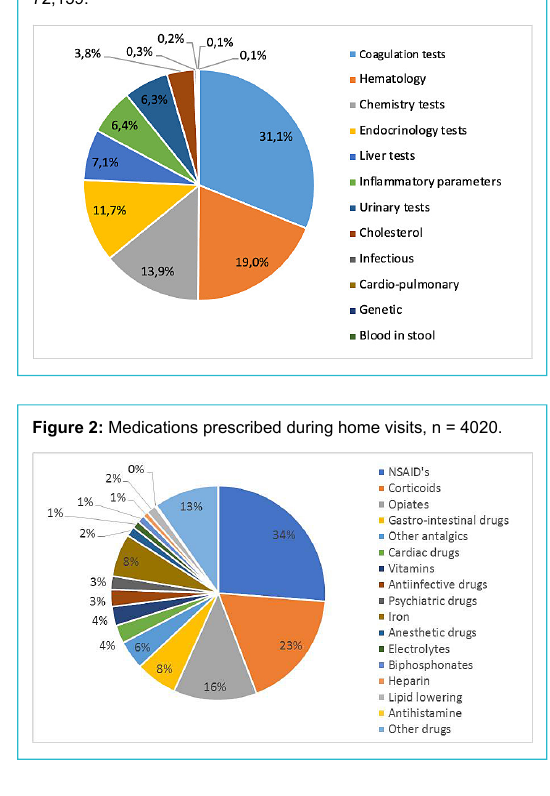
Table 1: Proportion of items billed during home visits and by emergency or